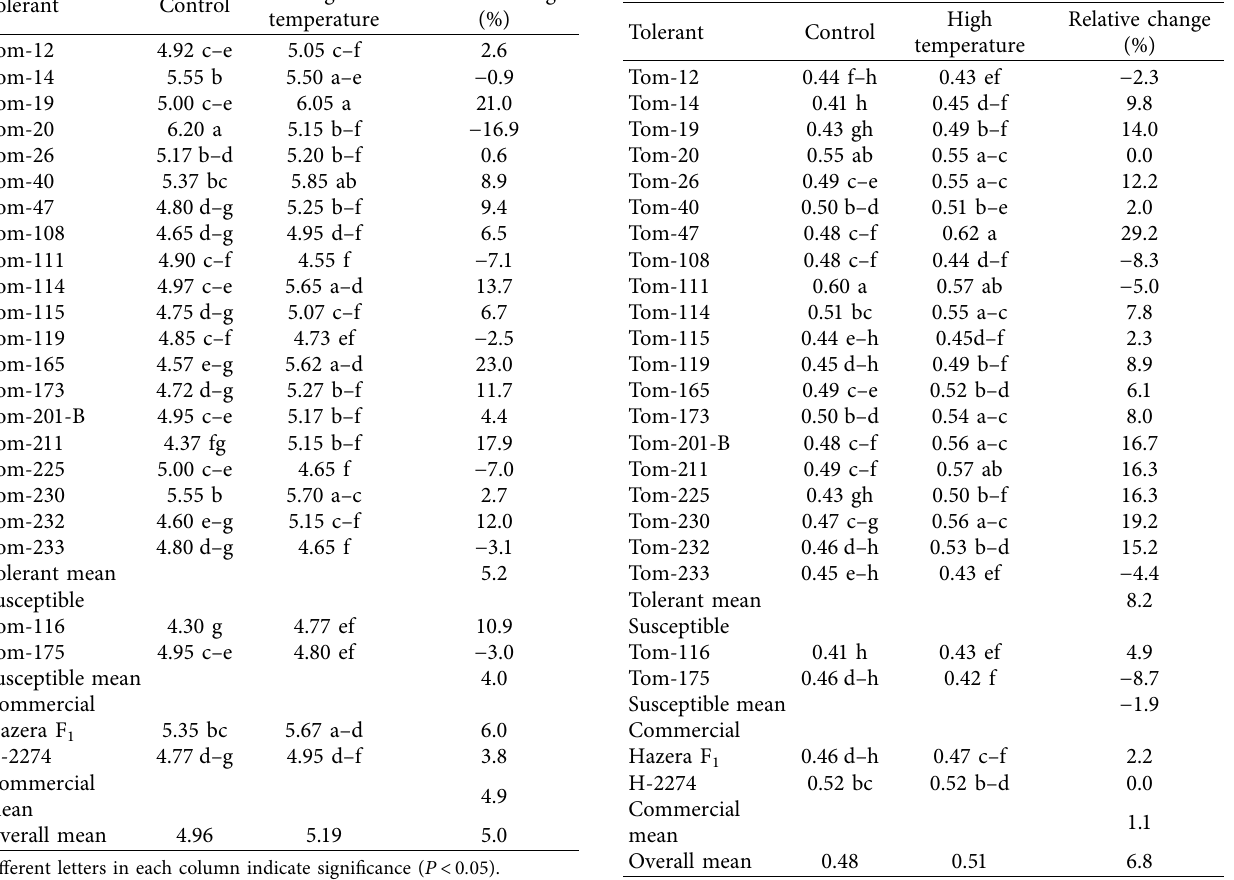
Table 4: Titratable acidity (in terms of citric acid) of tomato fruits grown under control and high-temperature stress ((g citric acid/ 100ml juice).